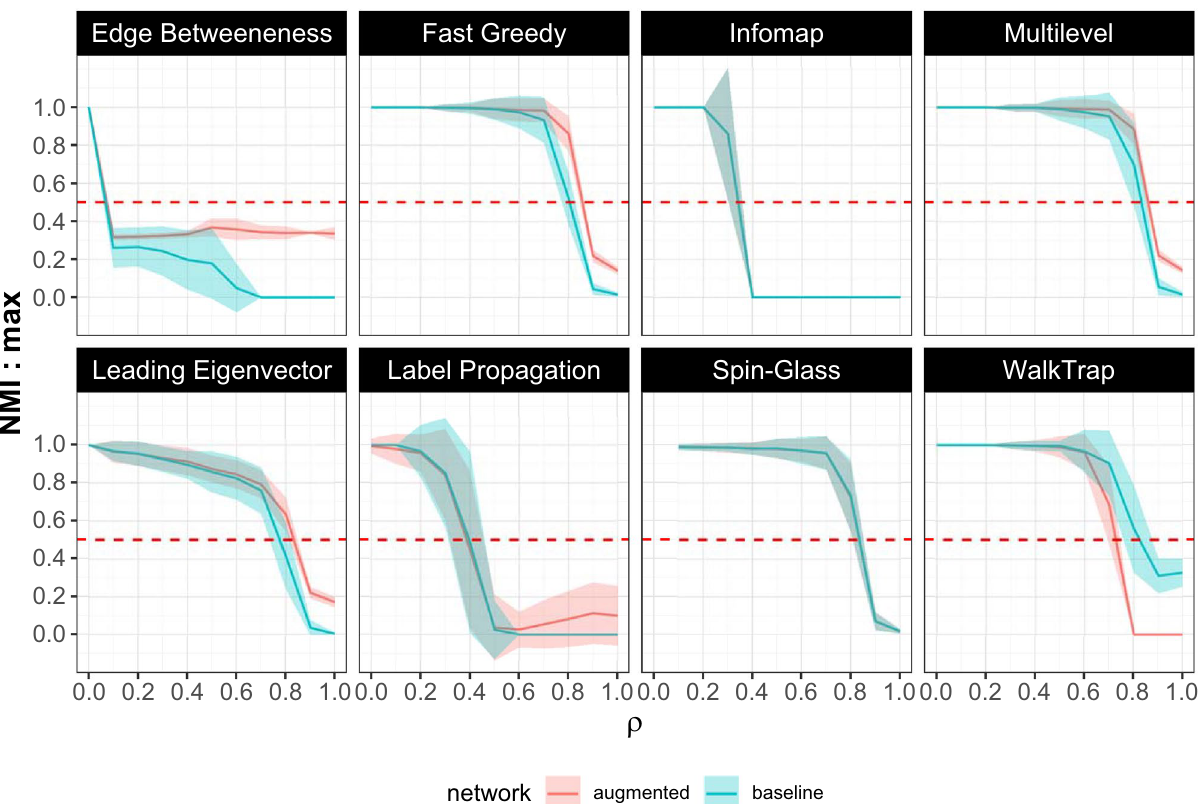
Figure 3. The performances of the 8 community detection algorithms are shown on the “baseline” (cyan) and “augmented” (pink) networks respectively. The y-axis tracks the Normalized Mutual Information value for each algorithm for every value of ρ , that determines the extent of randomness in the agents’ behavior. The solid line tracks the mean NMI score for the 100 simulations for every value of ρ , while the ribbons indicate the standard deviation around the mean. As ρ increases, NMI values drop. Fast Greedy, Multilevel, WalkTrap and Spin-Glass outperform the others even when the randomness is substantial. With the augmented networks, while the performances of FG and ML are significantly enhanced, that of WT